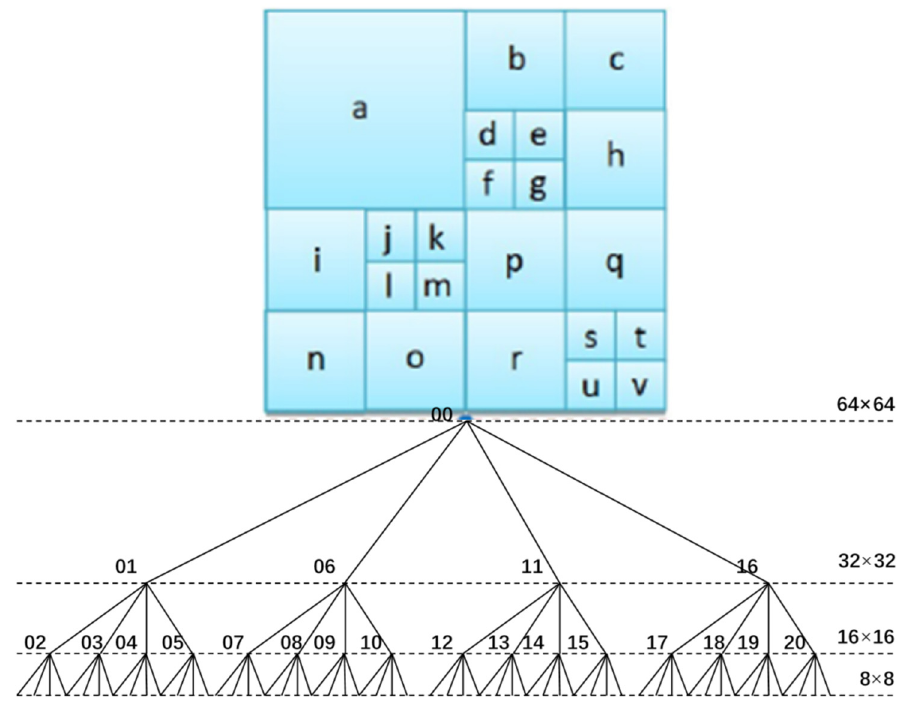
Figure 1. Partition of CU and its corresponding coding tree structure.